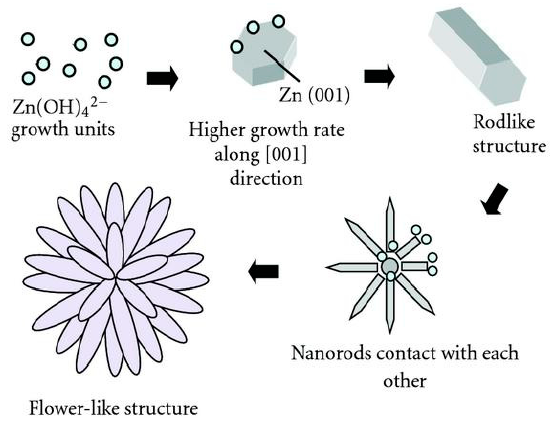
Figure 18. Schematic displaying the evolution of ZnO nanorods and ZnO nanoflowers from [Zn(OH) 4 ] 2 − growth units. Reproduced from [239] under the Creative Commons Attribution License.